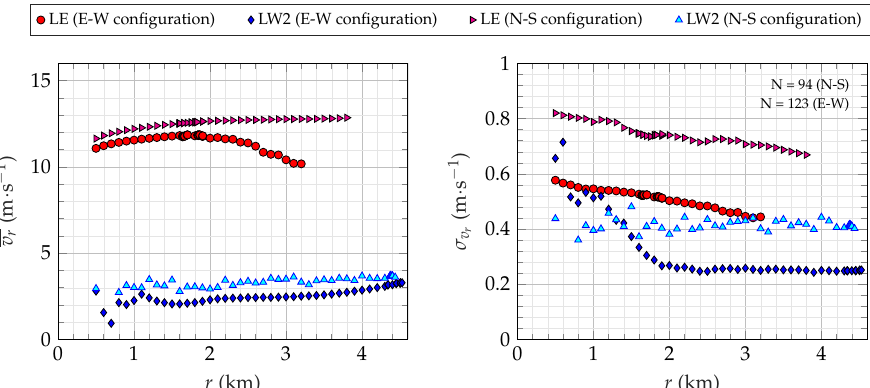
( right ) of the r 10 m s − 1 . ≥ ·